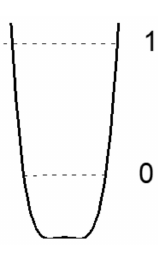
Figure 4. Proton potential function for an extremely strong hydrogen bond (“ultrashort, centered HB”), d O ··· O < 2.3